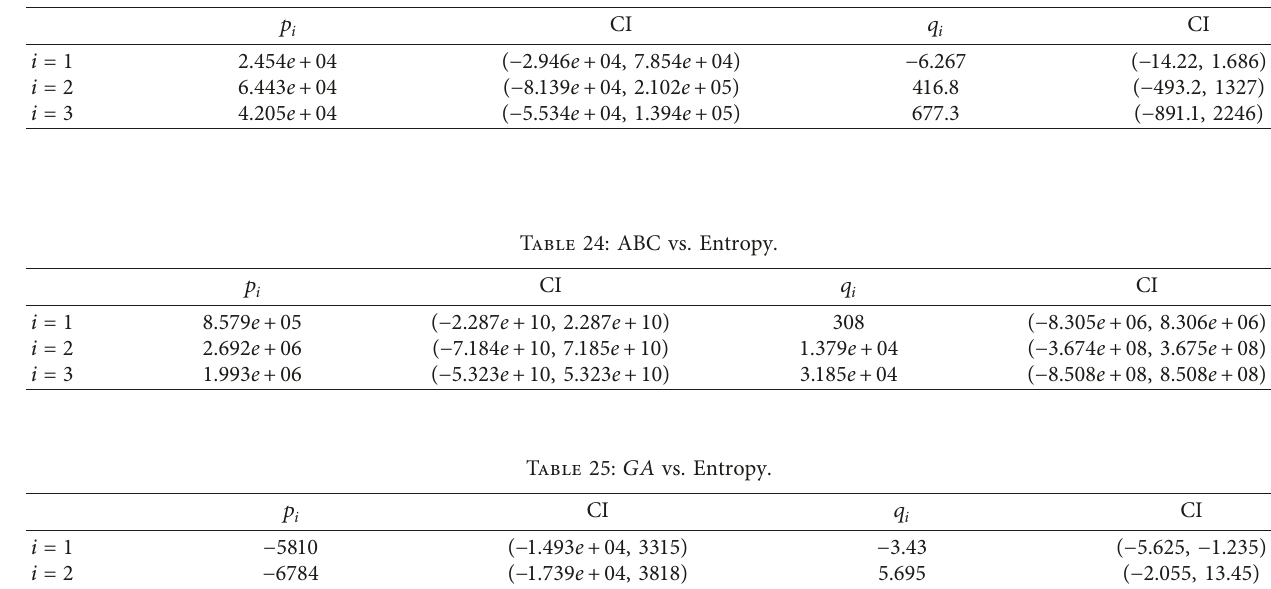
Table 23: R − 1/2 vs. Entropy.